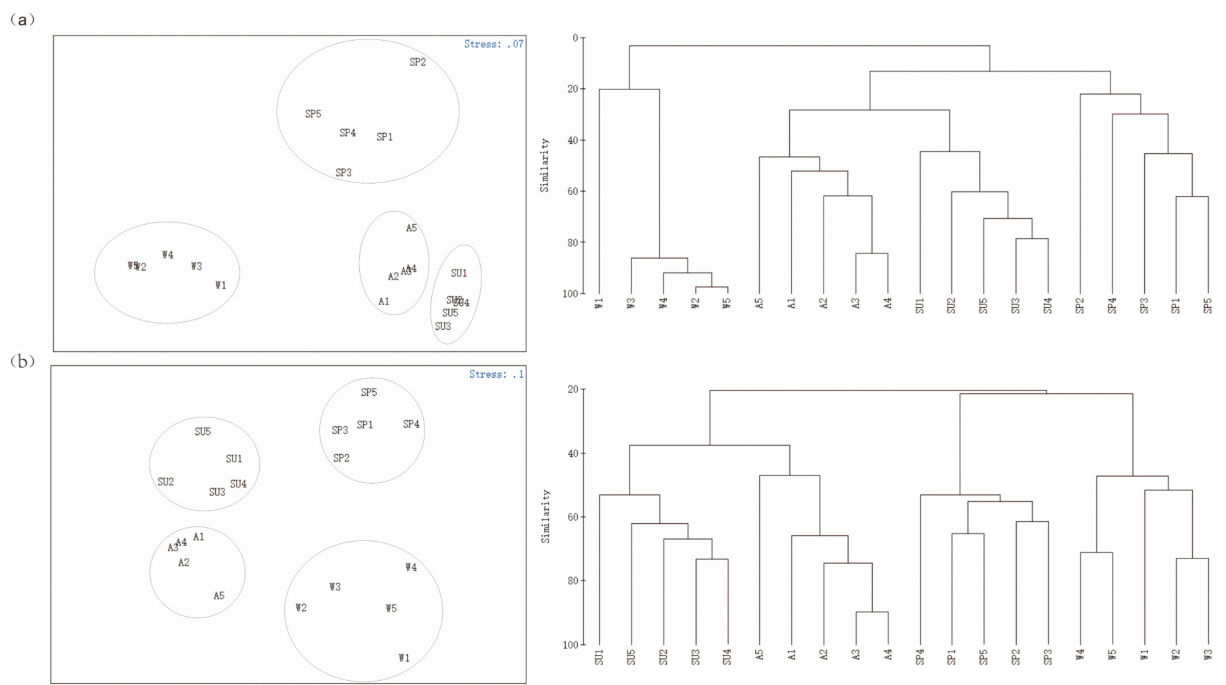
Figure 7. NMDS sorting diagram based on multidegree data and a similarity clustering analysis